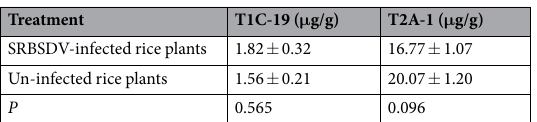
Table 2. Cry protein contents in SRBSDV-infected transgenic rice.